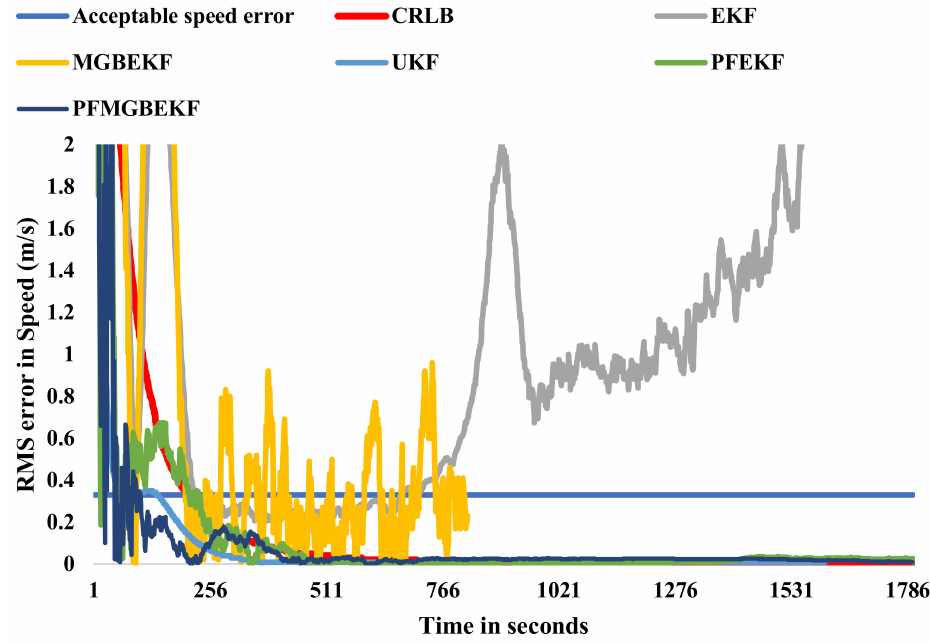
Figure 10. RMS error in speed estimate of the